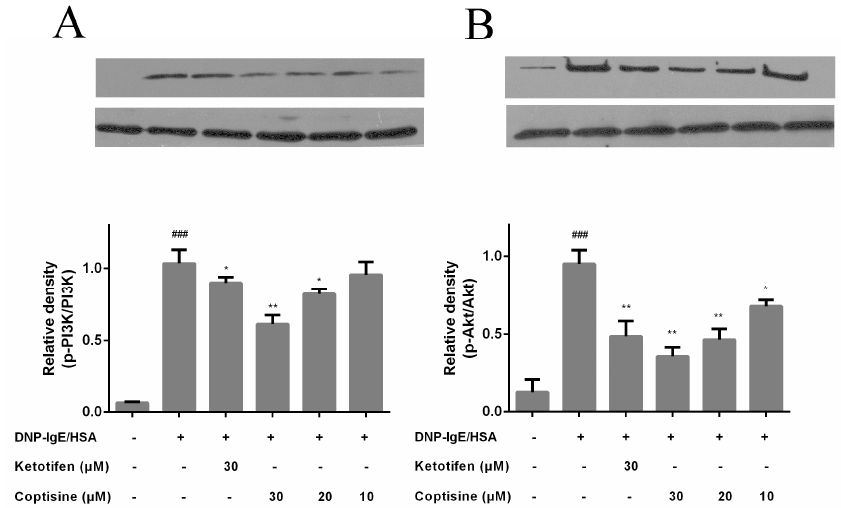
Figure 6. Effect of coptisine on PI3K/Akt signaling in RBL-2H3 cells. The protein level and relative expression of ( A ) PI3K, ( B ) Akt were determined with Western blot. All data were expressed as the mean ± SE. * p < 0.05, ** p < 0.01, in comparison with DNP-IgE/HSA group; ### p < 0.001 in comparison with control group.